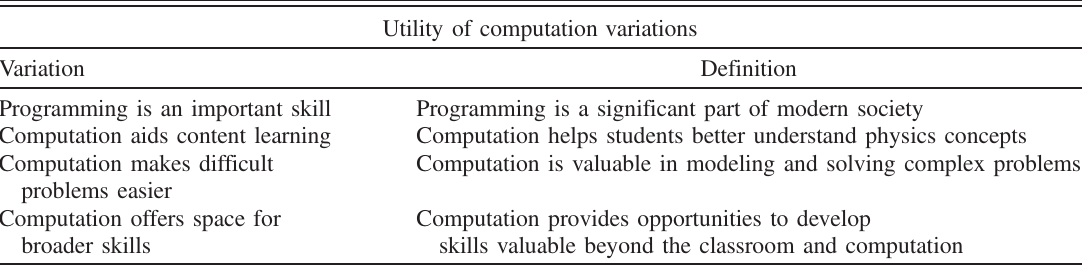
TABLE IX. Variations within the utility of computation theme, describing what learning assistants perceive the usefulness of computation to